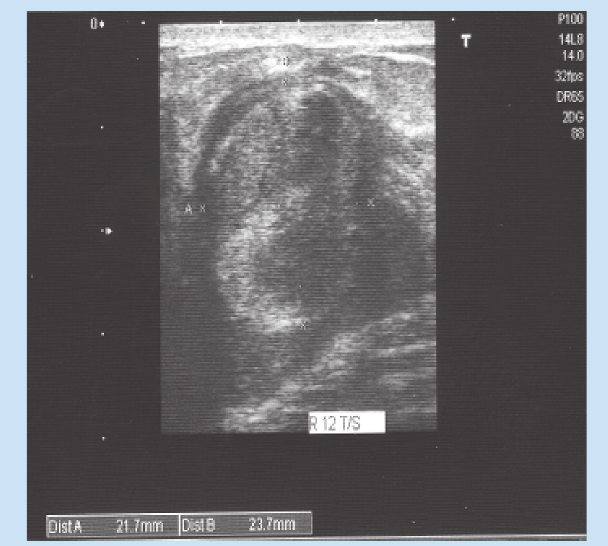
Fig. 2a. Case 2: High-frequency linear ultrasound of lesion in right breast – transverse section.